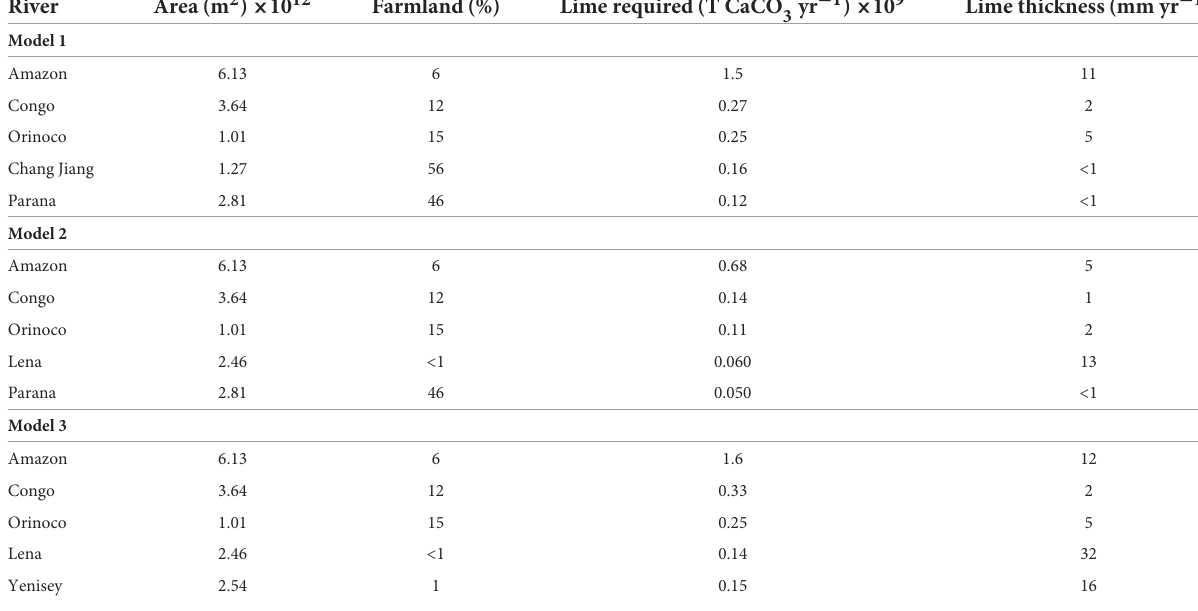
TABLE 2 The calculated thickness of lime required to be spread on farmland each year to achieve the estimated SDC (soil dissolution capacity) for Model 1, and estimated PTCC (potential transport capacities of carbon) for Models 2 and 3.